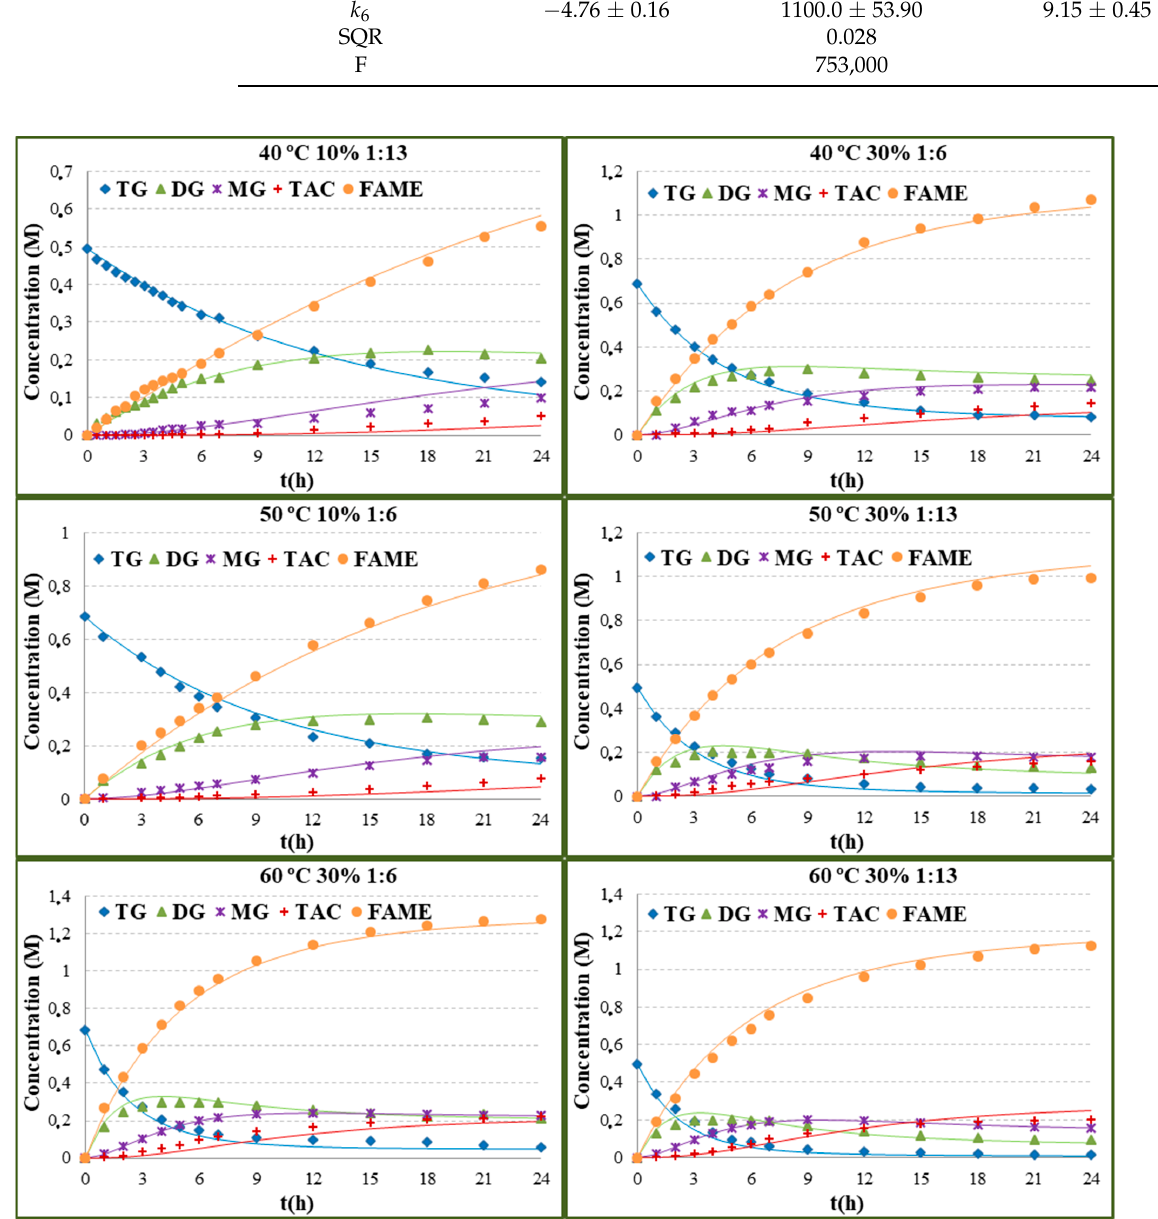
Figure 4. Fitting of the kinetic model to data of several selected methyl acetate-castor oil triglycerides interesterification runs (run details in each subfigure title: temperature -°C-, percentage of enzyme per mass castor oil and molar ratio castor oil:triacetin). The fitting was performed to data from all 12 runs at the same time.